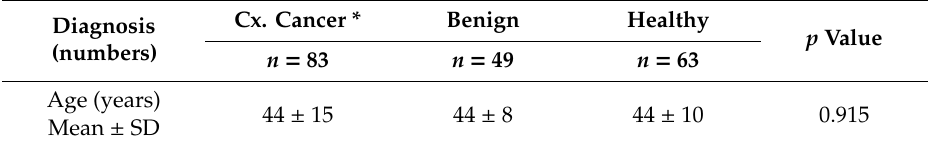
Table 1. Patients by group and